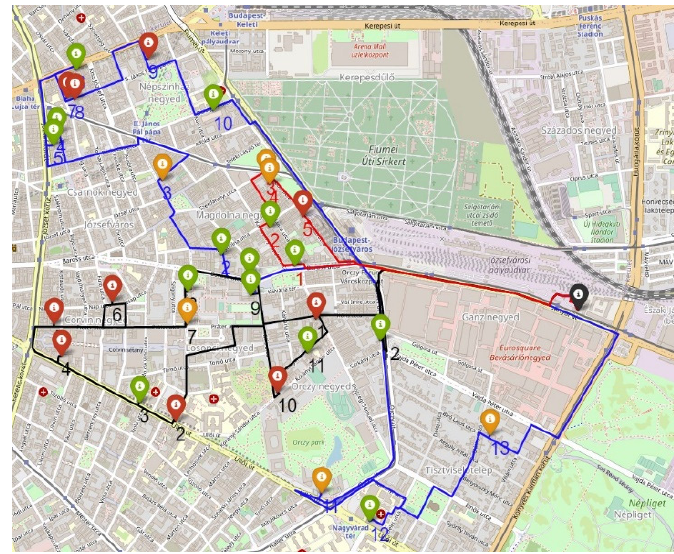
Figure 7. Actual routes when using PSO.